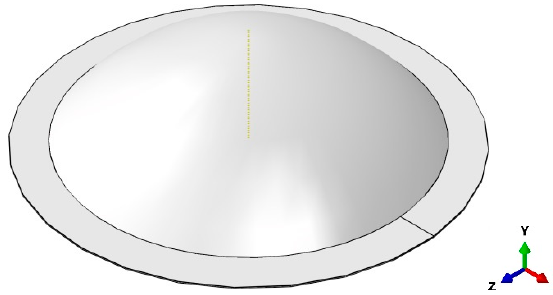
Figure 5. The finite element analysis model of the rupture disc.